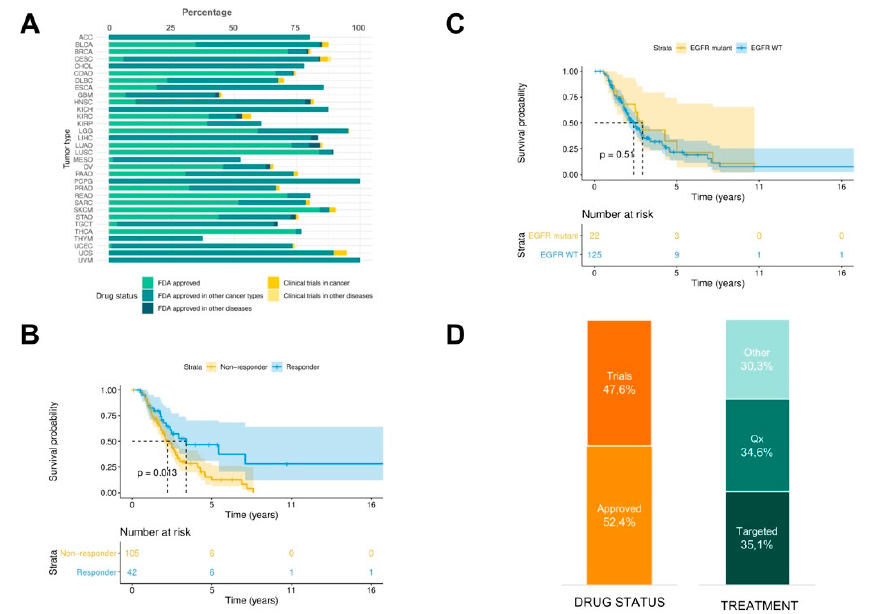
Figure 2. PanDrugs analysis in the Genomic Data Commons effort and The Cancer Genome Atlas (GDC-TCGA) cohort. ( A ) PanDrugs in silico prescription results for each tumour type in GDC-TCGA cohort. Bar colour represents drug status. Only those treatments showing Gene Score > 0.6 were considered. ( B ) Kaplan–Meier plot for responders and non-responders to EGFR inhibitor (EGFRi) treatment. Responders include cases identified by PanDrugs as a priori sensitive to the treatment. Non-responders include cases identified by PanDrugs as a priori resistant or without evidence of drug response. ( C ) Kaplan–Meier plot for EGFR-mutant and EGFR wild type cases treated with EGFR inhibitors. ( D ) PanDrugs prescription for EGFRi non-responder patients by drug status and type of treatment. (Qx: chemotherapy).